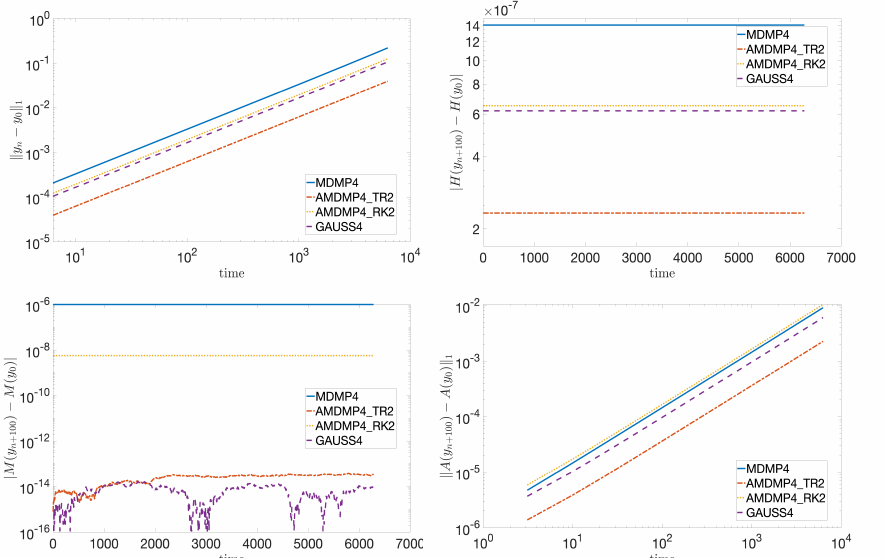
Figure 1. Results for the fourth-order MDMP (solid lines), Gauss (dashed lines), AMDMP_TR2 (dash-dotted lines) and AMDMP_R2 (dotted lines) methods applied to the Kepler problem computed at each period.